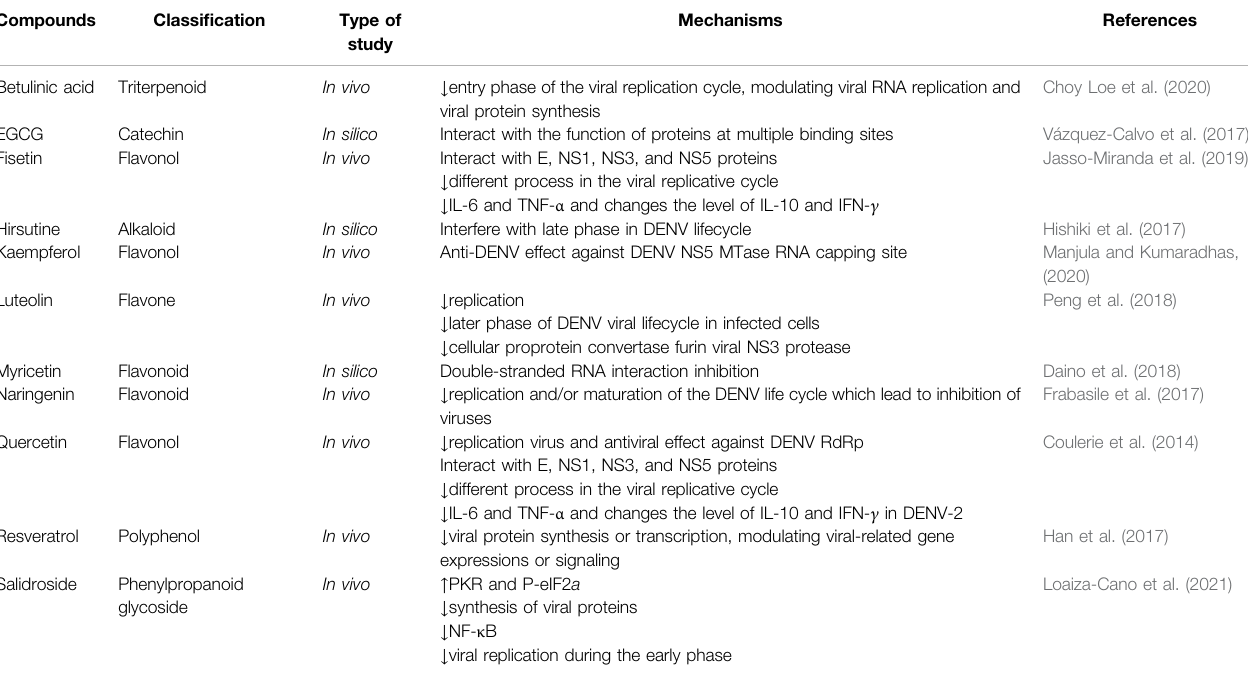
TABLE 2 | Preclinical evidence on the use of candidate phytochemicals against DENV and related neuropharmacological responses.